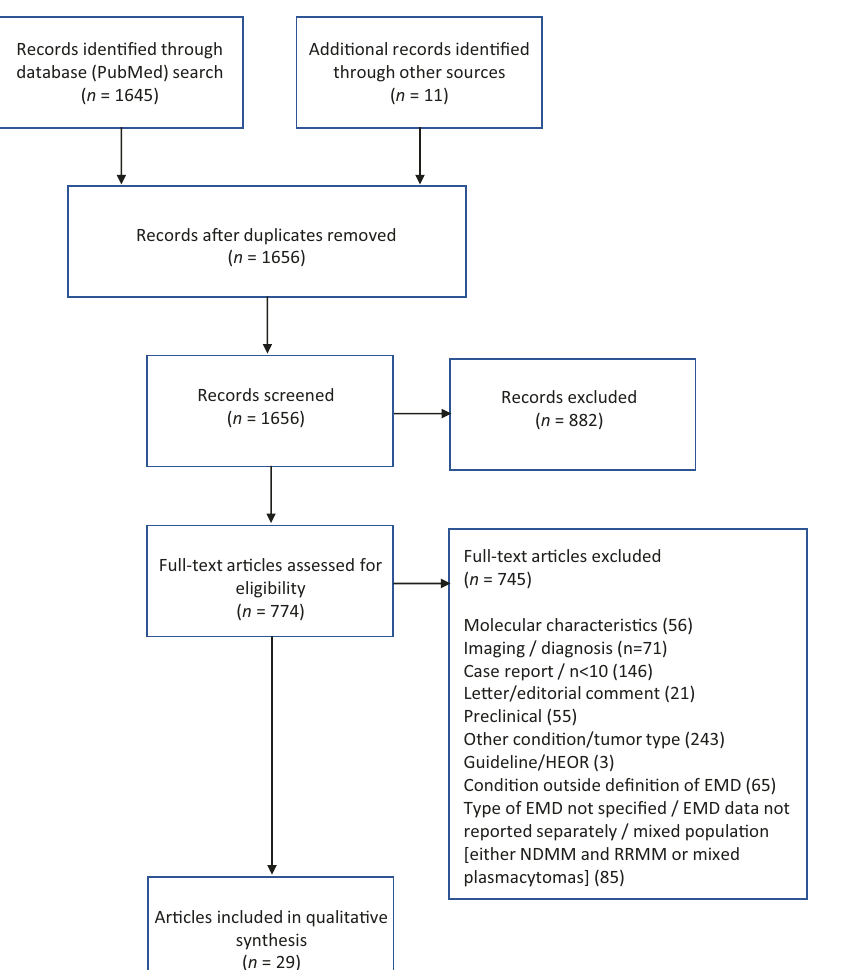
Fig. 1 PRISMA fl ow diagram for qualitative